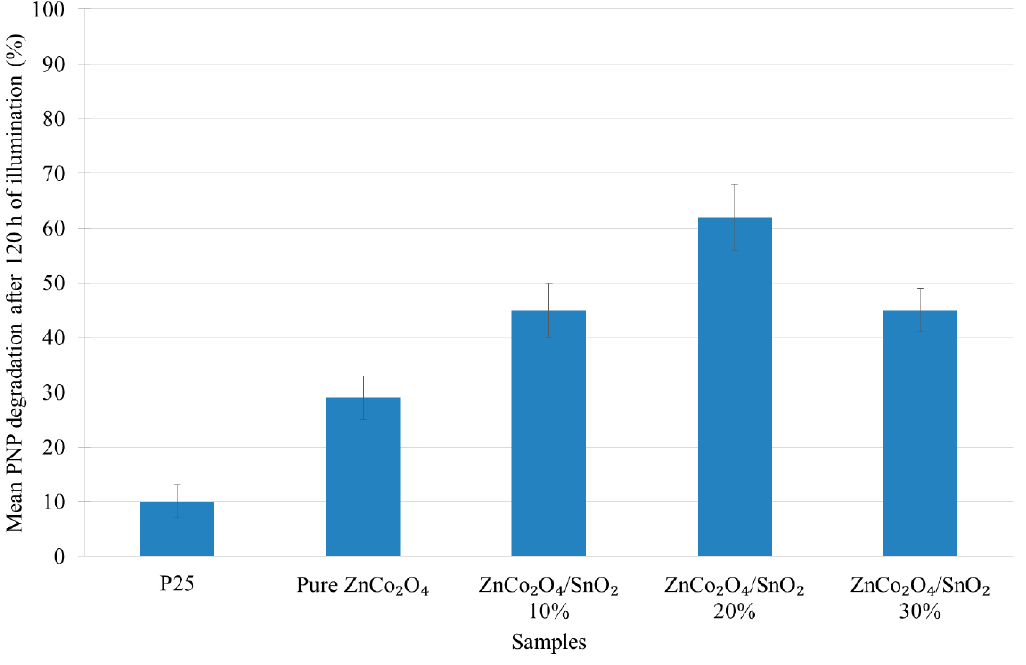
Figure 12. Mean PNP degradation (%) under visible light for all samples after the four recycling cycles (corresponding to five catalytic tests of 24 h each, with isolation of the sample and drying stages in between).